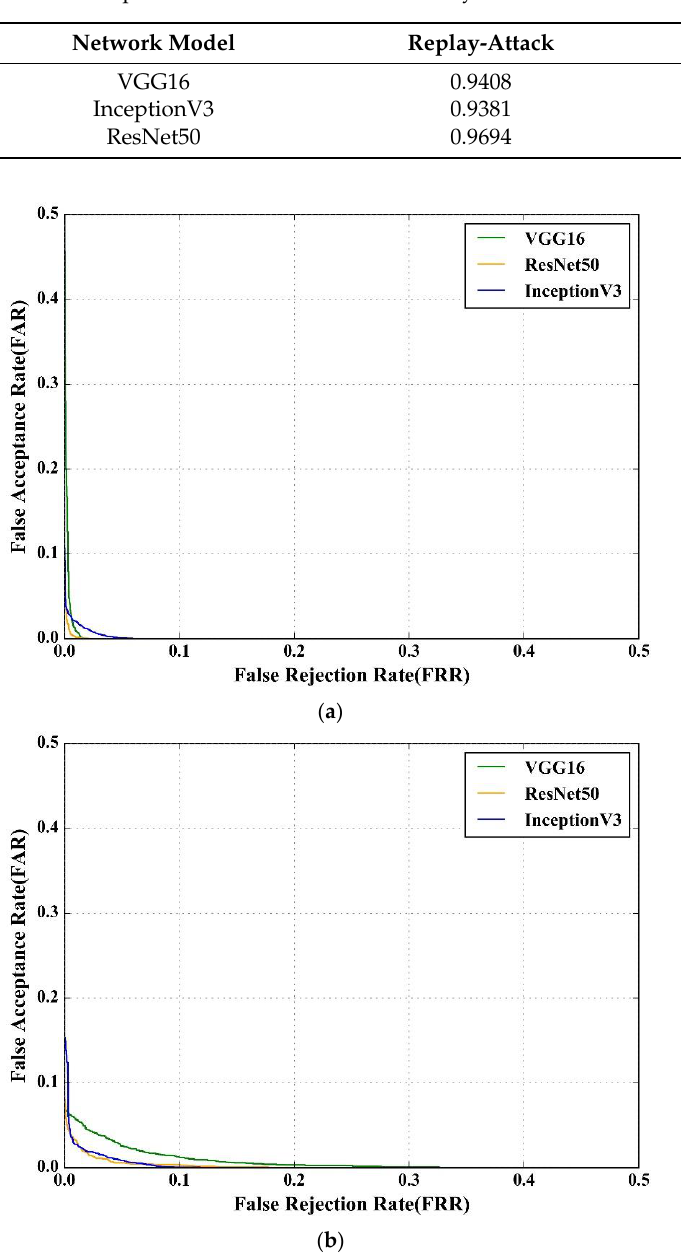
Table 1. Comparison table of results for accuracy of network model detection.